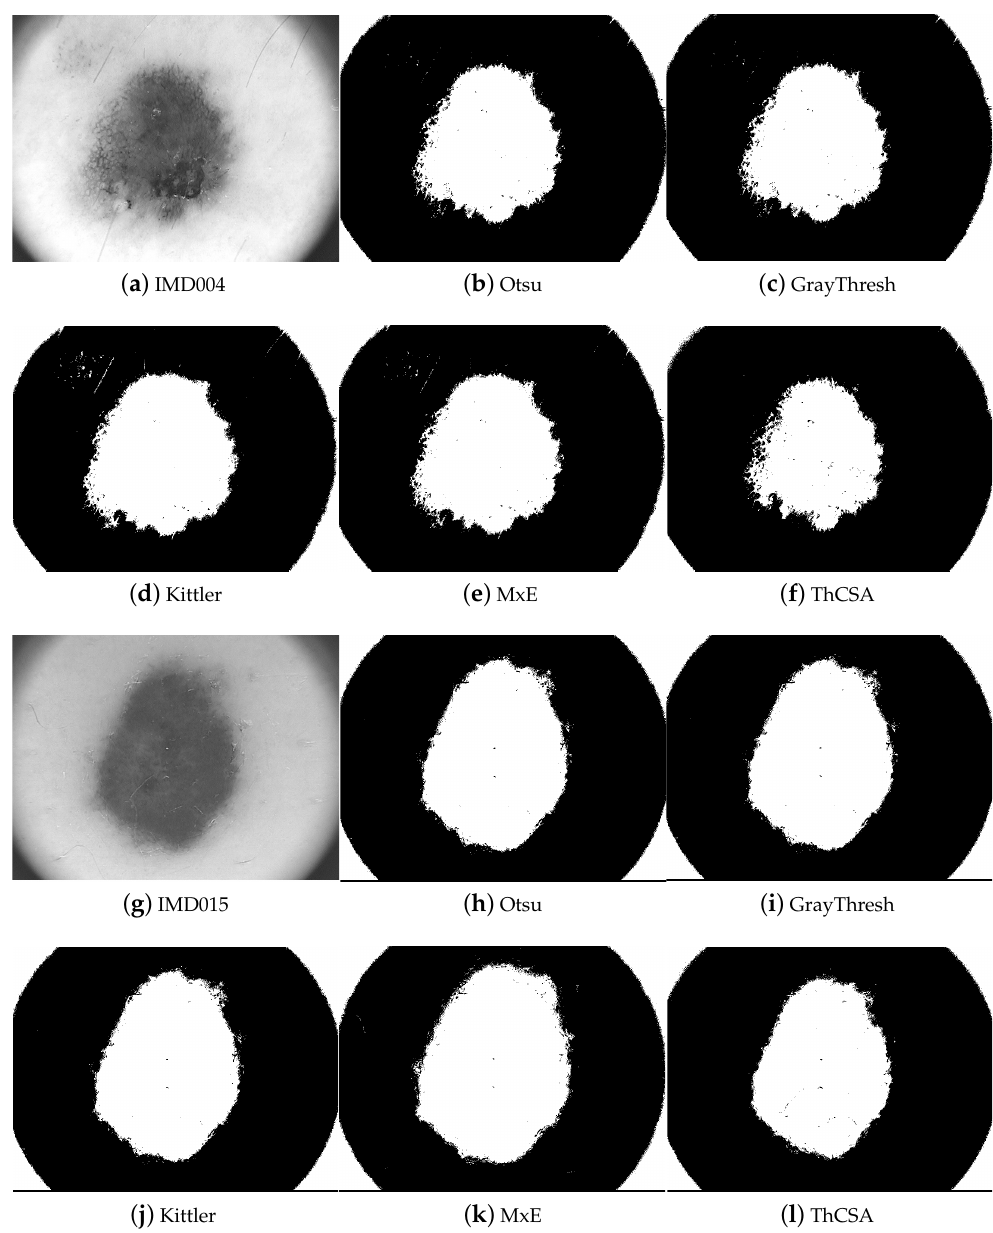
Figure 5. Gray-scale and processed images for IMD004 and IMD015 using the thresholding methods Otsu, GrayThresh, Kittler, MxE, and ThCSA,